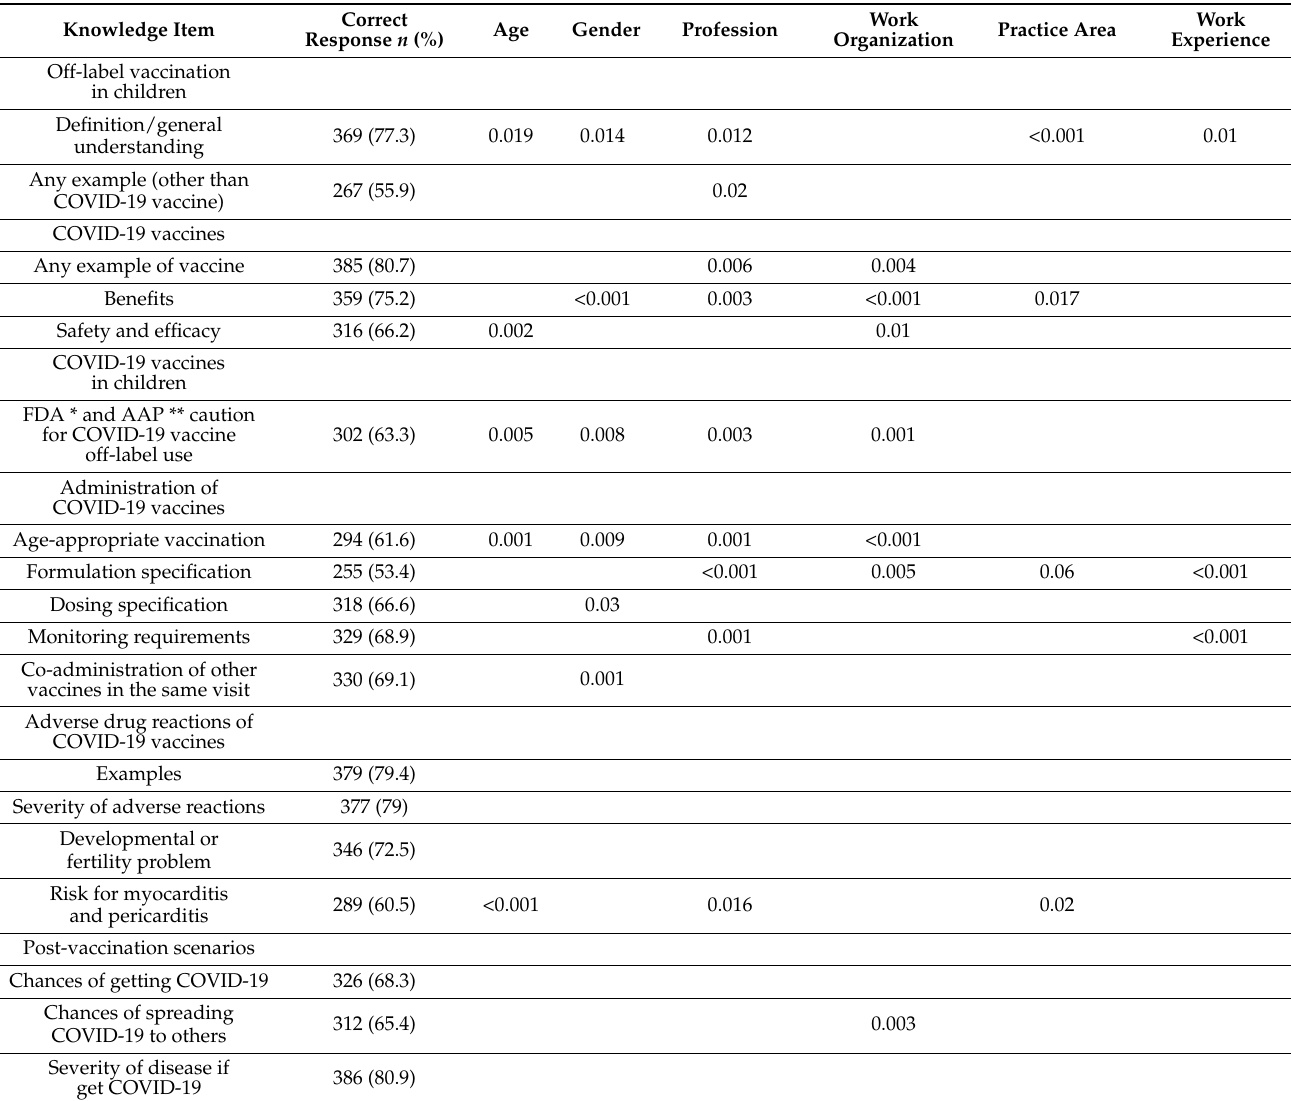
Table 2. Respondents’ knowledge towards off-label COVID-19 vaccination in